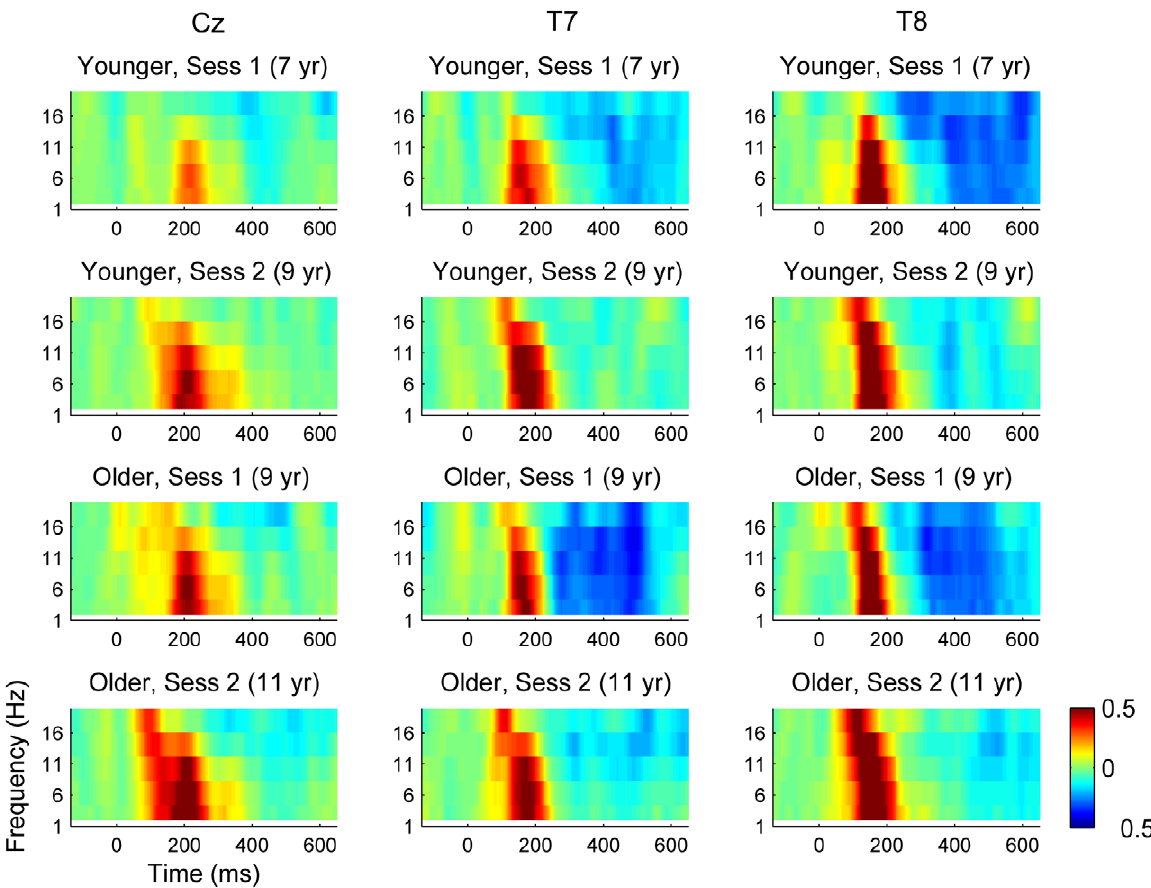
Figure 3. ERSP at electrodes Cz, T7 and T8. Mean ERSP by time (x-axis) and frequency (y-axis) in relation to group and session, with colors indicating range from -.5 (deep blue=power decrease) through zero (green) to .5 (deep red=power increase). ANOVA indicated a general increase in event-related power relative to baseline across all frequencies and all electrodes with age.